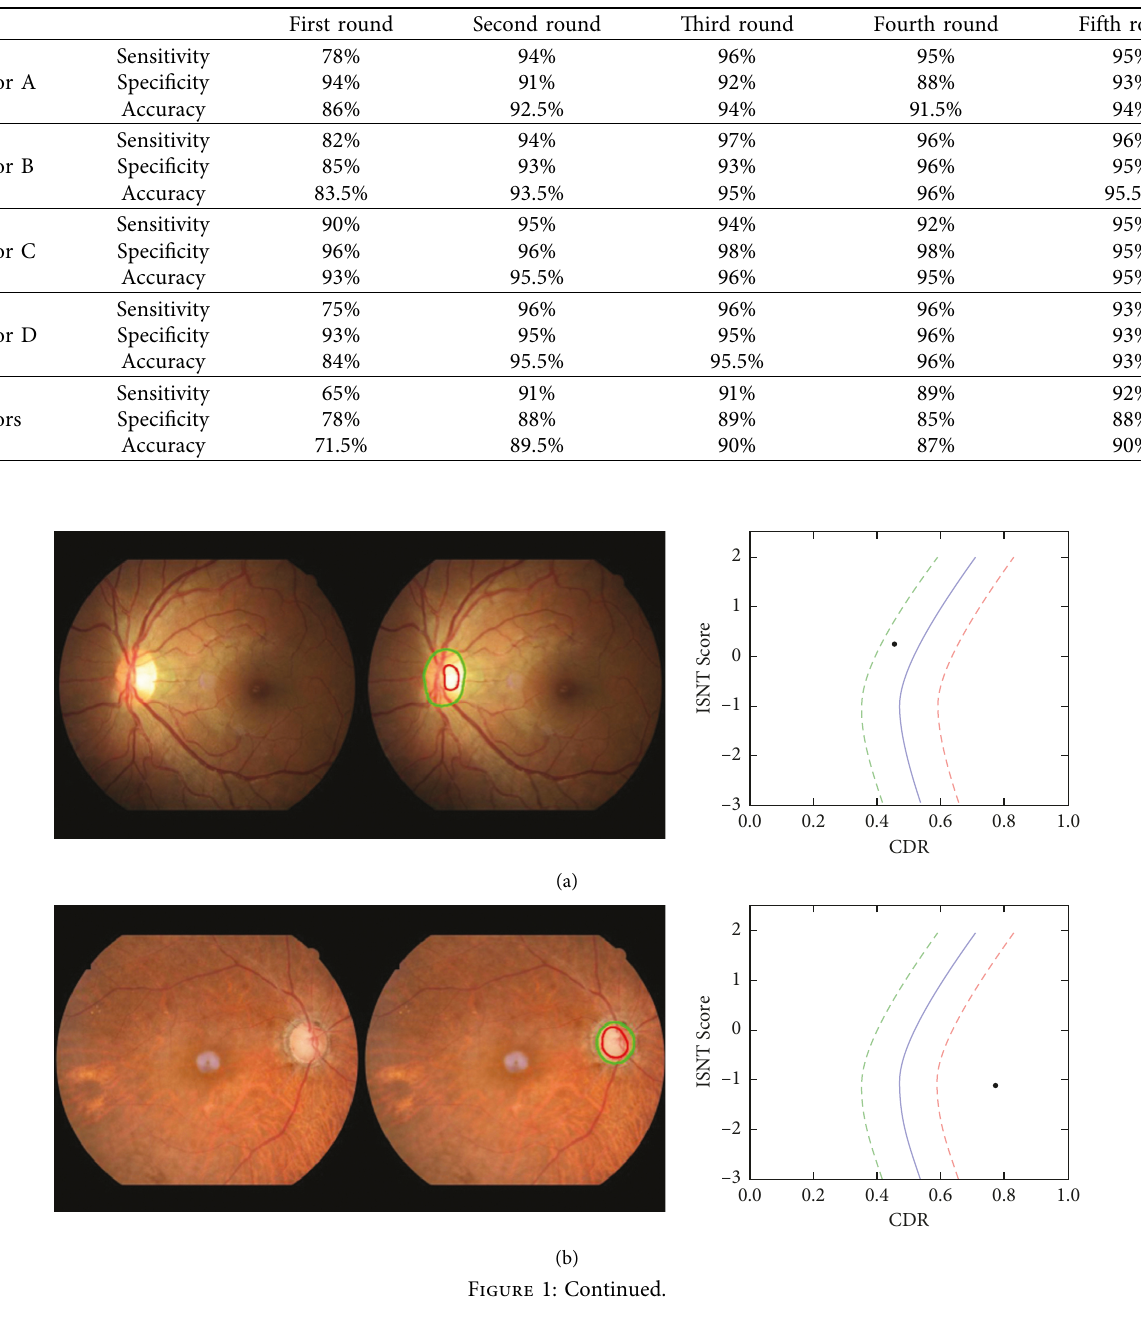
Table 2: Diagnosis data of four doctors.